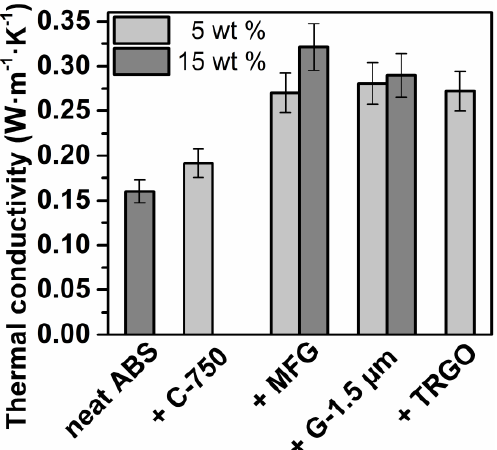
Figure 5. Thermal conductivity of carbon/ABS nanocomposites as a function of the filler type and content.